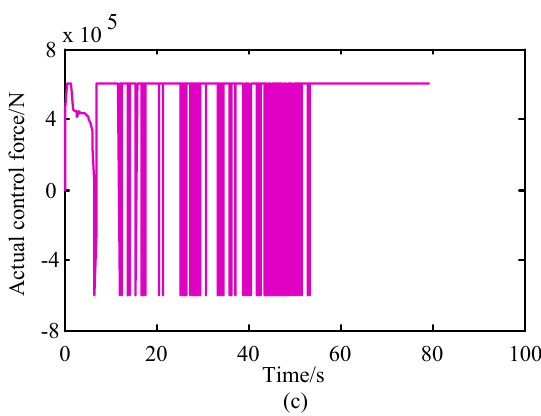
Figure 7. Control performance for HSTs without anti-actuator saturation: ( a ) position tracking error, ( b ) velocity tracking error, ( c ) actual control force.